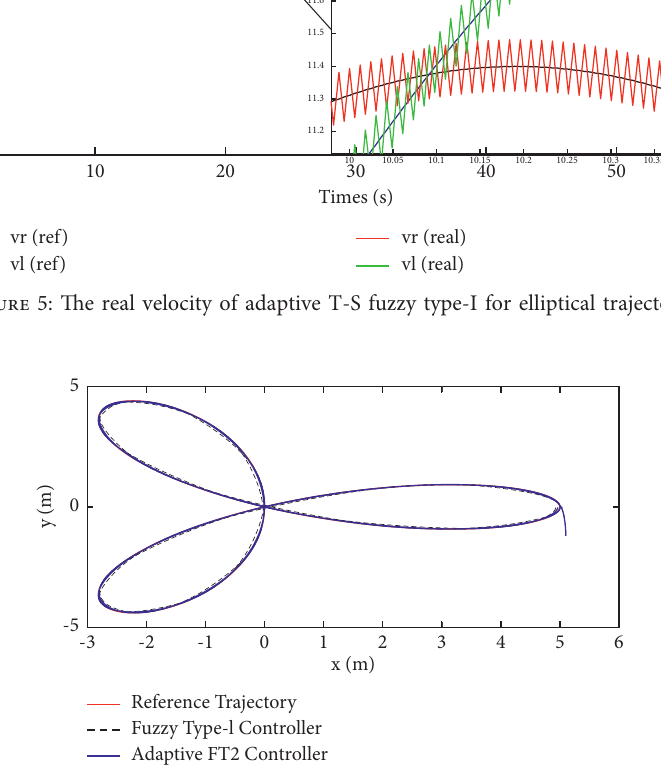
Figure 6: The output trajectory of adaptive interval fuzzy type-II and T-S fuzzy type-I controller for trifolium trajectory.